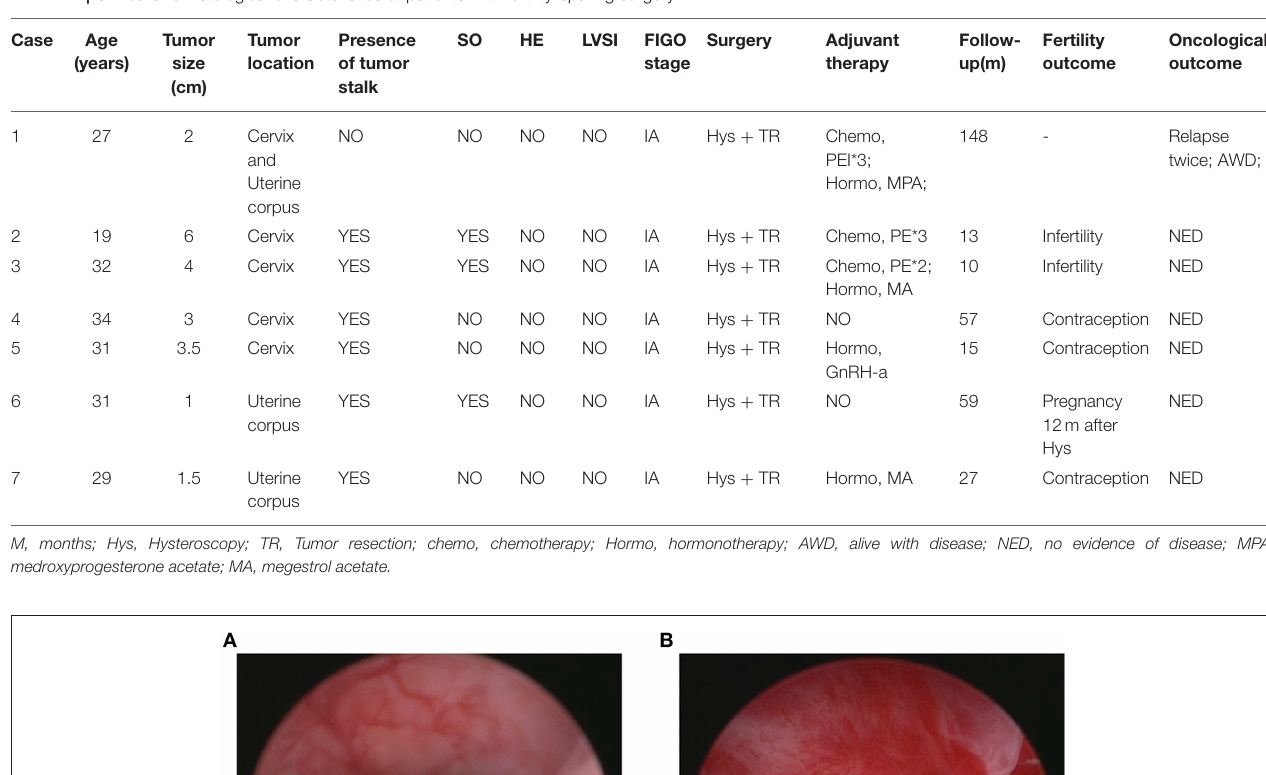
SO HE LVSI FIGO